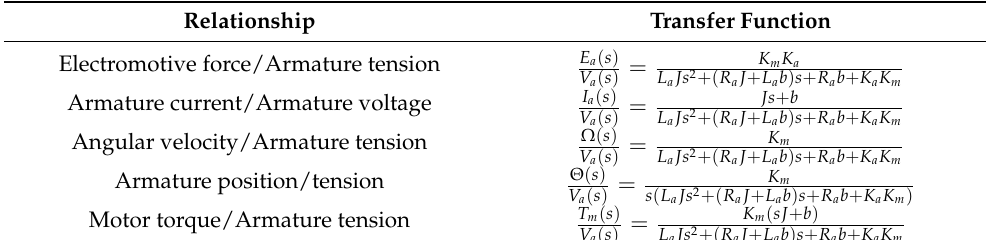
Table 4. Function transfers of DC motor according to the inputs and outputs.